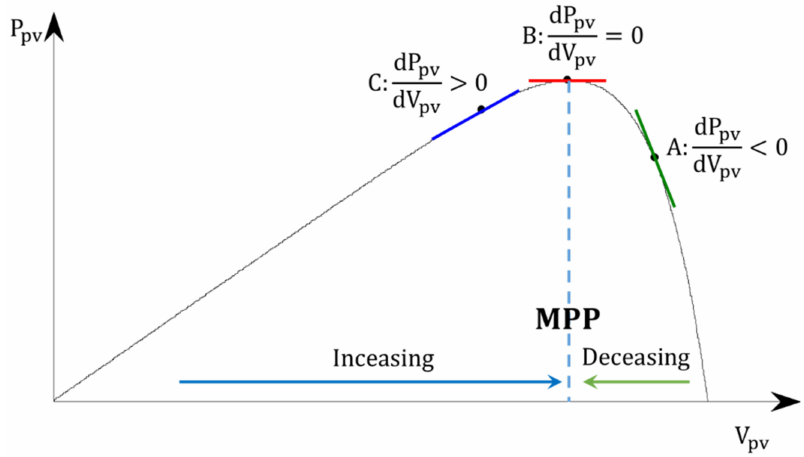
Figure 13. P-V curve and slope